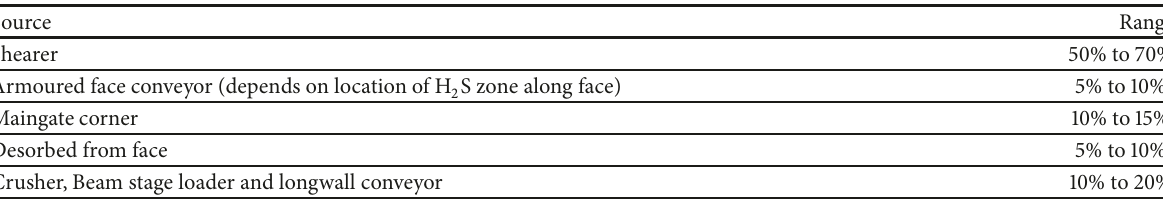
Table 2: Sources of H 2 S during mining.